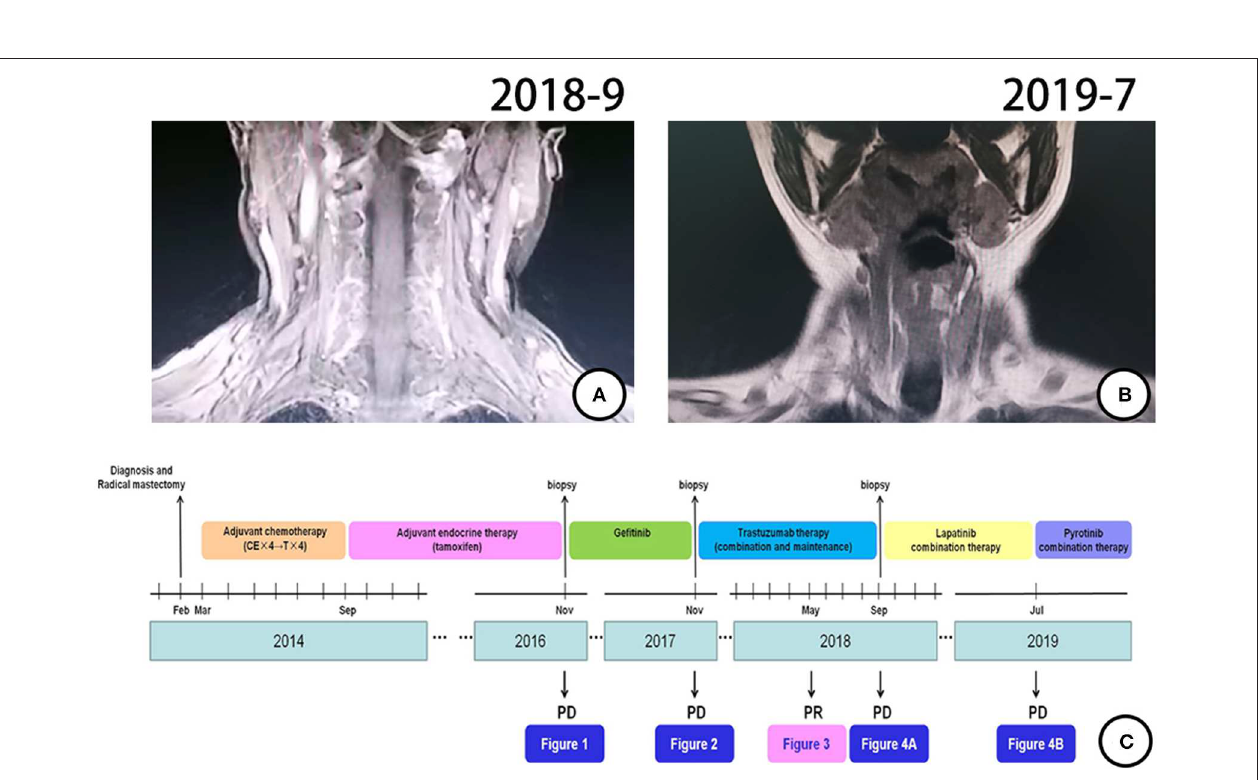
FIGURE 4 | Treatment process and effect evaluation of the patient. (A) New metastatic lymph node in left neck confirmed by MR in September 2018. (B) New metastatic lymph node of right neck confirmed by MR in July 2019. (C) Review of treatment process (from February 2014 to November 2019).